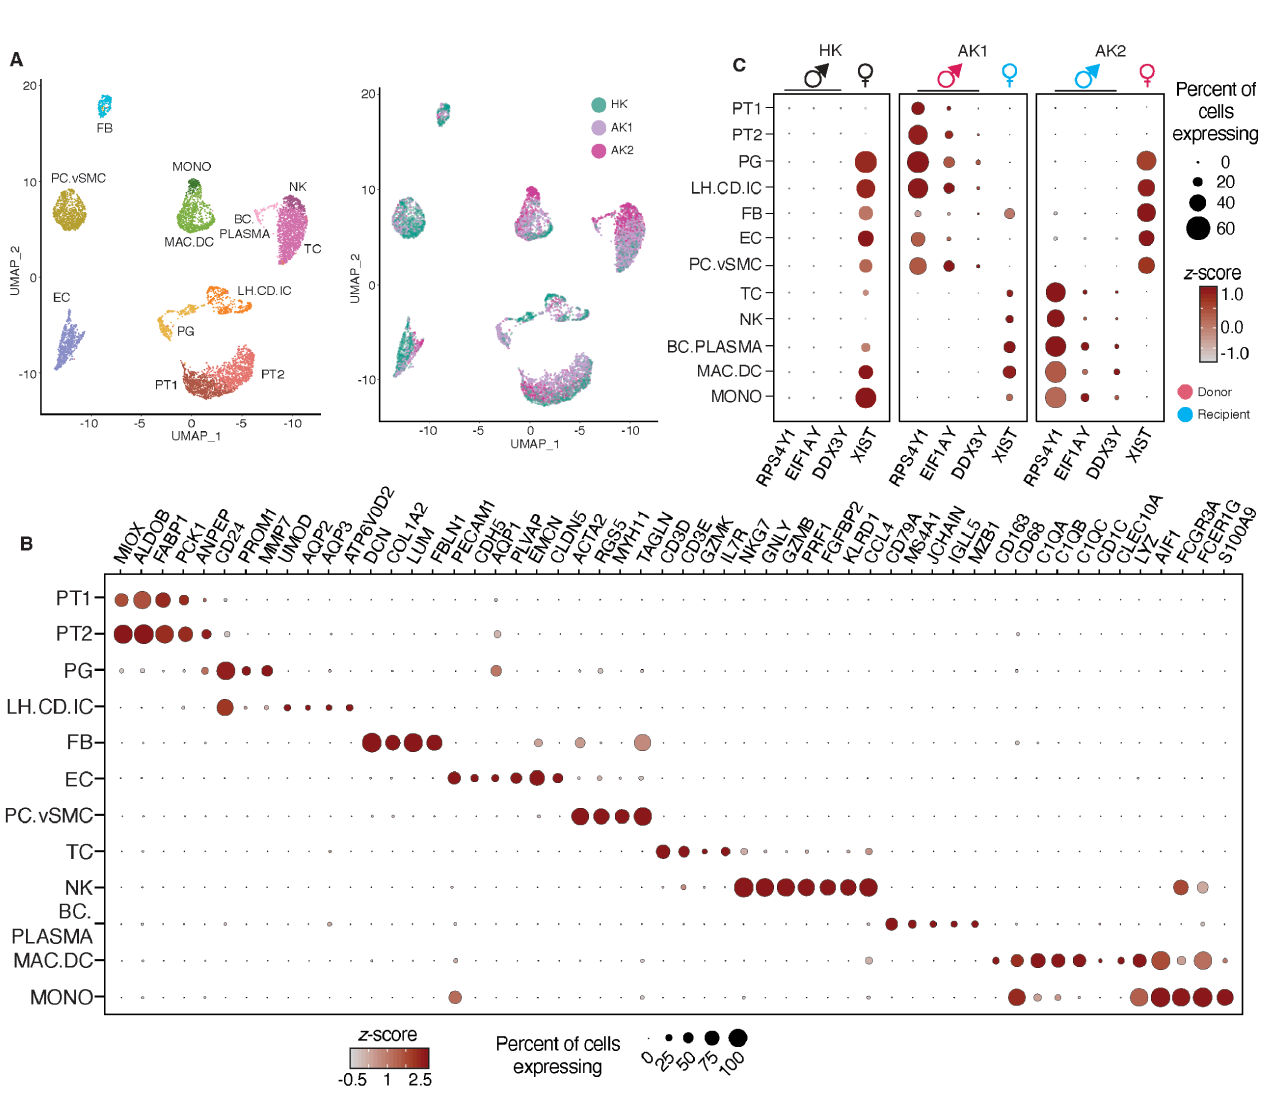
Fig 2. scRNA-seq applied to kidney allografts differentiated cell types and resolved recipient and donor origin based on sex-specific gene expression. (A). Uniform manifold approximation and projection (UMAP)-based visualization of 7217 individual cells obtained from the three kidney biopsy tissues. Left Panel: UMAP-based visualization in which different clusters represent different cell types. PT1 and PT2, proximal tubular cells 1 and 2; PG, progenitor cells; LH.CD.IC, cluster of loop of Henle, collecting duct, and intercalated cells; FB, fibroblasts; EC, endothelial cells; PC.vSMC, cluster of pericytes and vascular smooth muscle cells; TC, T lymphocytes; NK, natural killer cells; BC.PLASMA, cluster of B lymphocytes and plasmablast cells; MAC.DC, cluster of macrophages and dendritic cells; and MONO, monocytes. Right Panel: UMAP-based visualization of the same cell clusters shown in the left panel in which the cells are colored by the samples. HK-healthy kidney biopsy tissue, AK1 and AK2-allograft kidney biopsy tissues. (B). Dot-plot showing expression of known lineage markers. The size of the dot represents the proportion of cells within each cluster expressing the marker. The intensity of the color represents the standard score for each marker across different cell clusters. (C). Dot-plot showing the annotation of donor/recipient origin of cells in each sample based on female ( XIST ) and Y chromosome ( RPS4Y1 , EIF1AY , and DDX3Y) -specific gene expression patterns. HK is a female donor kidney; AK1 is a female recipient of a kidney from a male donor; AK2 is a male recipient of a kidney from a female donor. XIST is a female-specifically expressed gene. XIST gene transcription produces X-inactive specific transcript (Xist) RNA, a non-coding RNA, which is a major effector of the X chromosome inactivation. The Xist RNA is expressed only on the inactive chromosome and not on the active chromosome. Males (XY), who have only one X chromosome that is active, do not express it. Females (XX), who have one active and one inactive X chromosome, express it. In HK biopsy (female kidney), all the cells in the kidney express XIST and none express the Y chromosome markers. In AK1 biopsy (male donor and female recipient), all the kidney parenchymal cells express Y chromosome markers whereas all the recipient-derived immune infiltrating cells express XIST . In AK2 biopsy (female donor and male recipient), all the kidney parenchymal cells express XIST whereas all the recipient-derived immune infiltrating cells express the Y chromosome